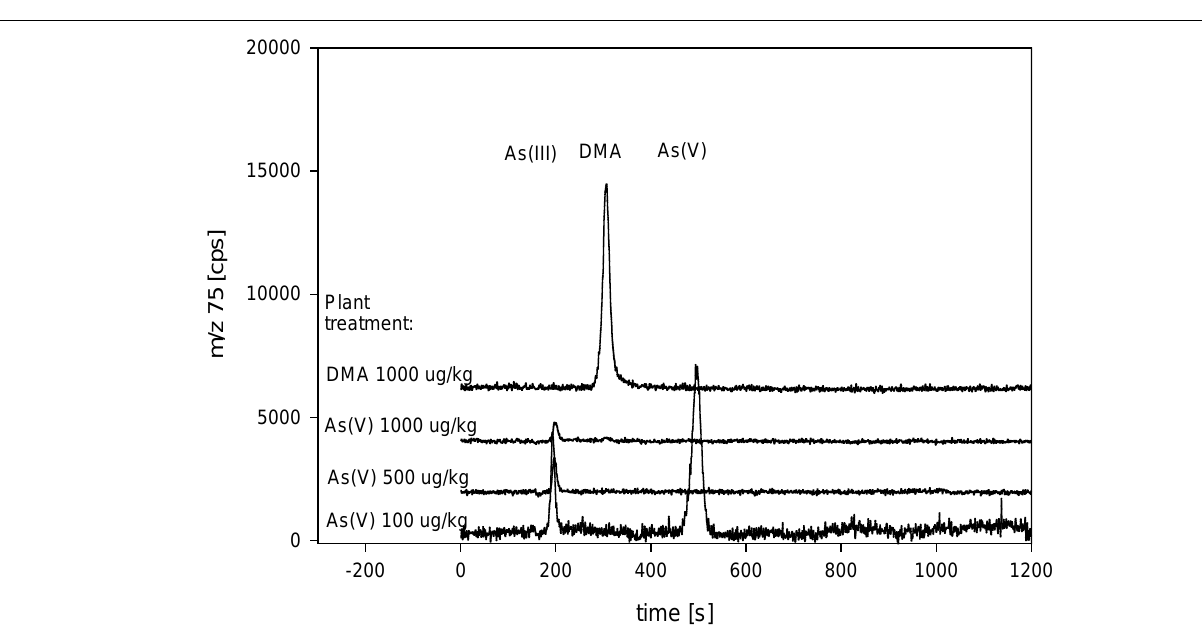
FIGUREA14 |Accurate mass MS and MS2 for isoleucine.